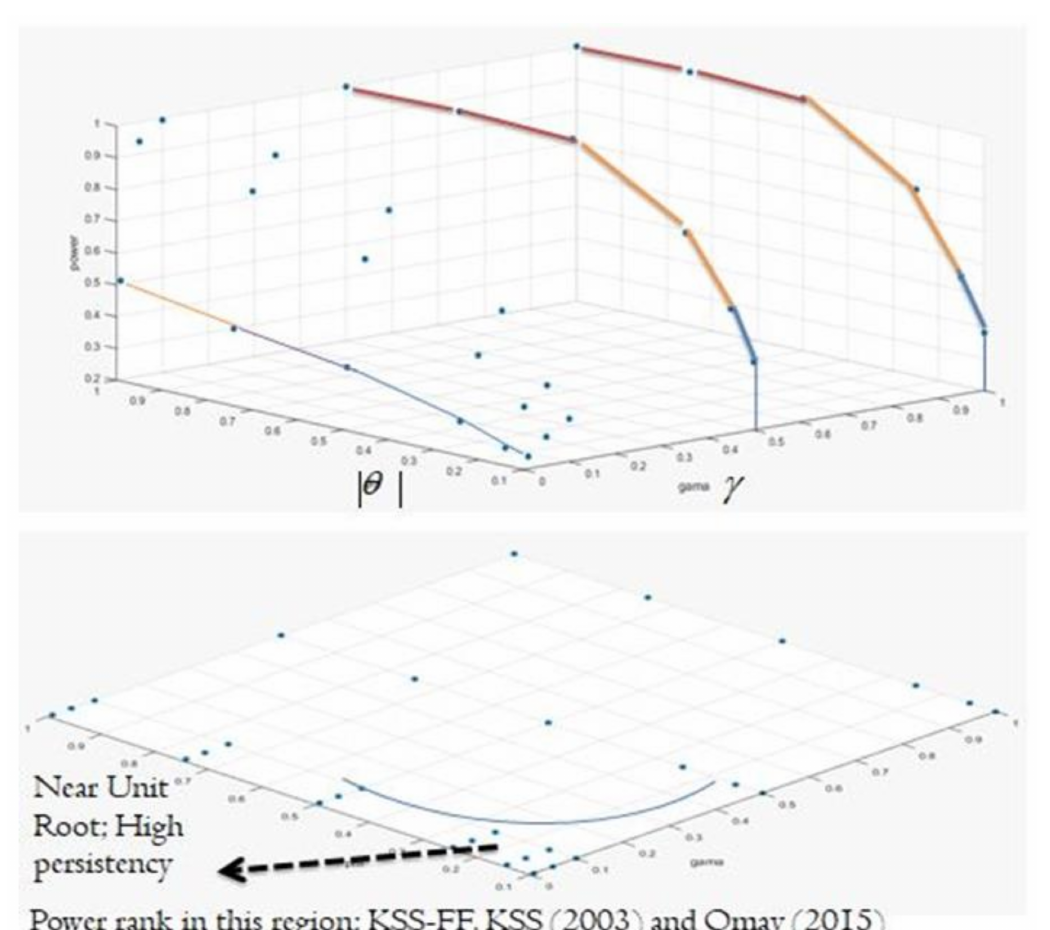
Figure 4. Power of the test and the region where the financial data are located: the panel on the top shows the power analysis in the 3D diagram, where the results are obtained by using alternative values of γ and θ . The power results located on the vertical axis change from high power colored by red to low power colored by blue. As the values of γ and θ increase, the power of the test increases as well. In the near unit root high-persistence area, the KSS-FF test proposed in our study becomes the most powerful test. The power of the KSS-FF test is already much higher than the other tests in other areas. That is, because financial variables exhibit the structure in the near unit root persistence area, one can say that the proposed KSS-FF statistic is more suitable to test for the stochastic properties of financial variables. This can be seen in the blue hyperbolic area of the projective graph at the